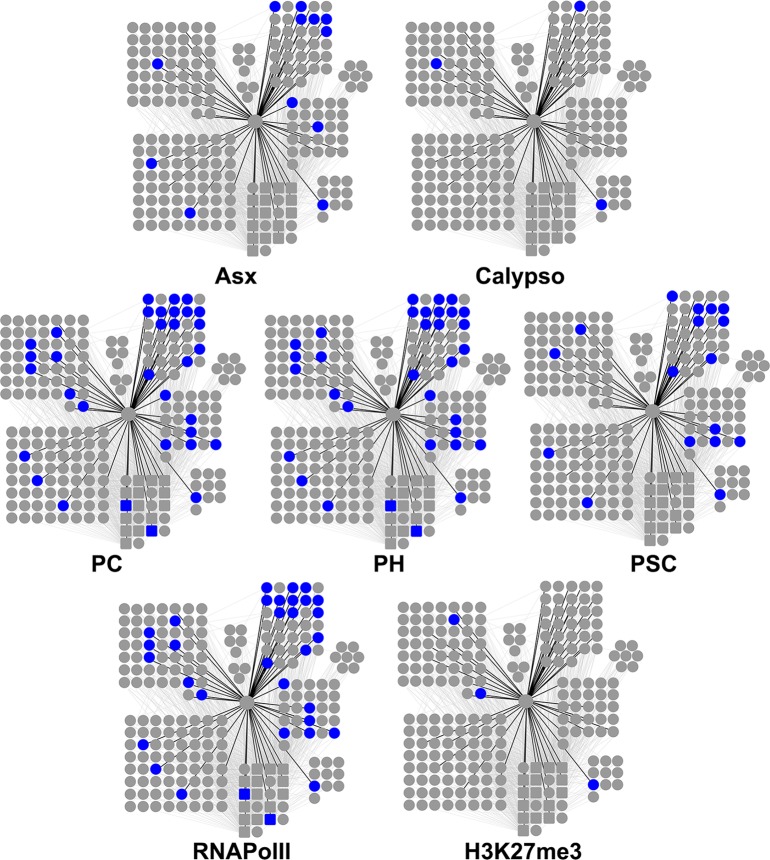
Genes bound by Asx, Calypso, Pc, Ph, Psc, or RNAPolII, or enriched in
H3K27me3 in the sub-network of 222 genes centred on Cyclin G.Bound genes are represented in blue.